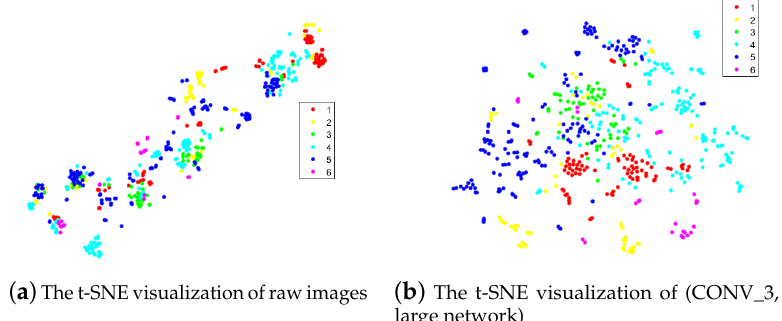
Figure 9. The t-SNE visualization of VAIS test set examples: ( a ) raw images; and ( b ) CONV_3 features using the large